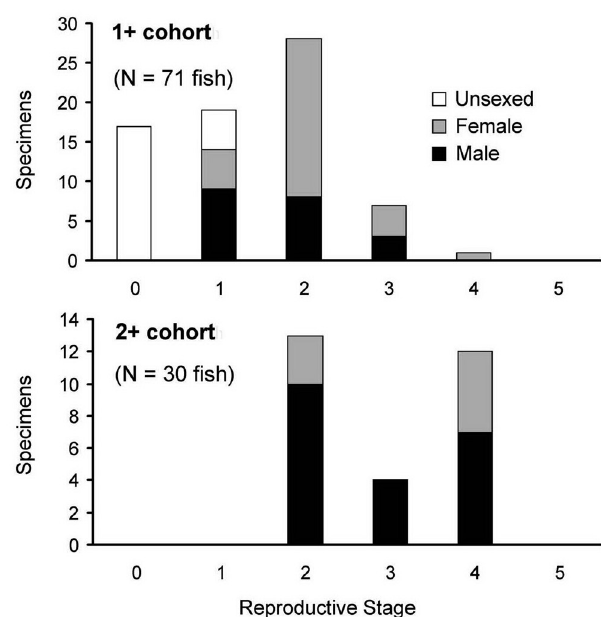
Fig. 10. Reproductive status and sex of Symphysodon haraldi from: (a), a single large colony in galhadas of Uxi Bay, lago Amanã, 1998; (b), shore scrub in Uxi Bay, 1998, (combined with specimens from shore scrub in lago Urini, 1999). Only specimens that were dissected for sex determination are included.